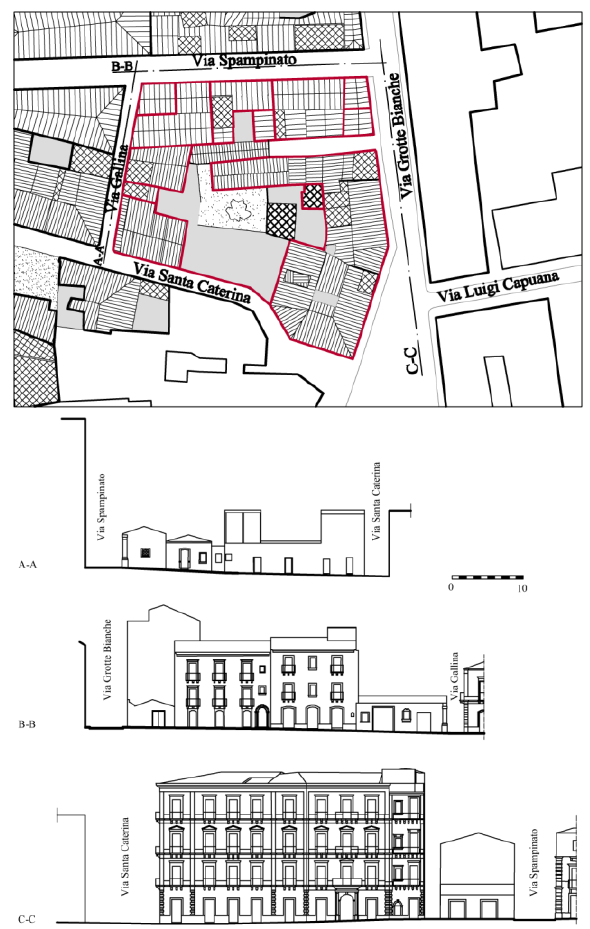
Figure 3 . view of the investigated area and metric drawings along the streets which highlight the narrowness of the alleys and the different building